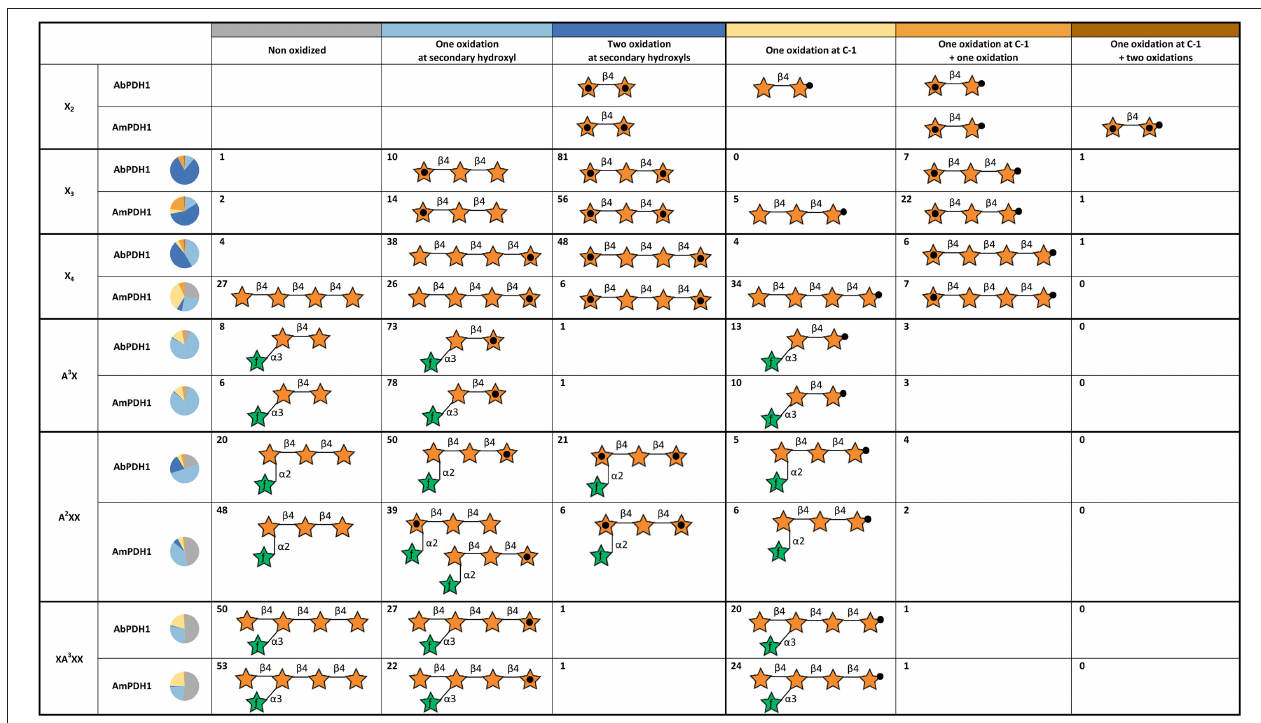
FIGURE 5 | Summary of main oxidation products and oxidized positions following xylooligosaccharide treatment by AbPDH1 and AmPDH1. Representative product structures are drawn for those representings > 5% of the reaction mixture; the symbol nomenclature for glycans was adopted from Varki et al. (2015). A black dot in the center of a star represents a secondary hydroxyl oxidation, and a black dot at the tip of a star represents oxidation at the reducing end C-1. The proportion of each reaction product is shown by the number in each cell and summarized by the pie chart shown in each